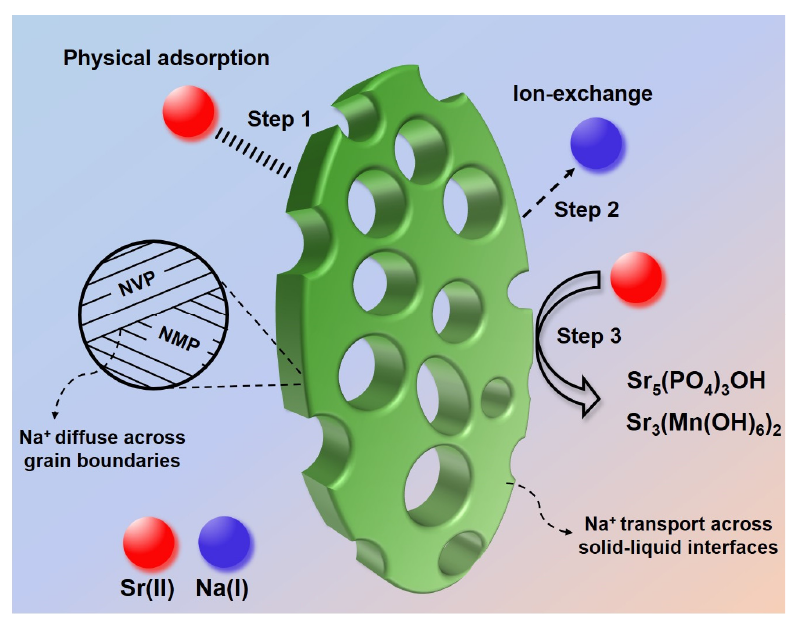
Figure 8. Mechanism of Sr 2+ adsorption onto NVP@NMP.